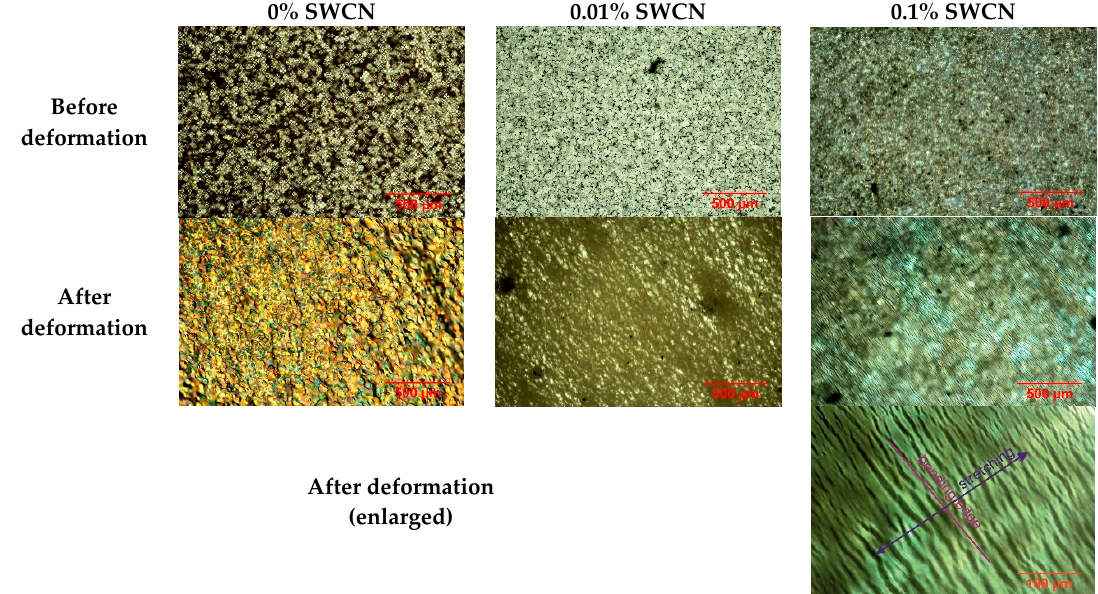
Figure 6. Optical texture for L , D -PLA and its mixtures with SWCN before and after mechanical deformations; room temperature, crossed polarizers (90°).